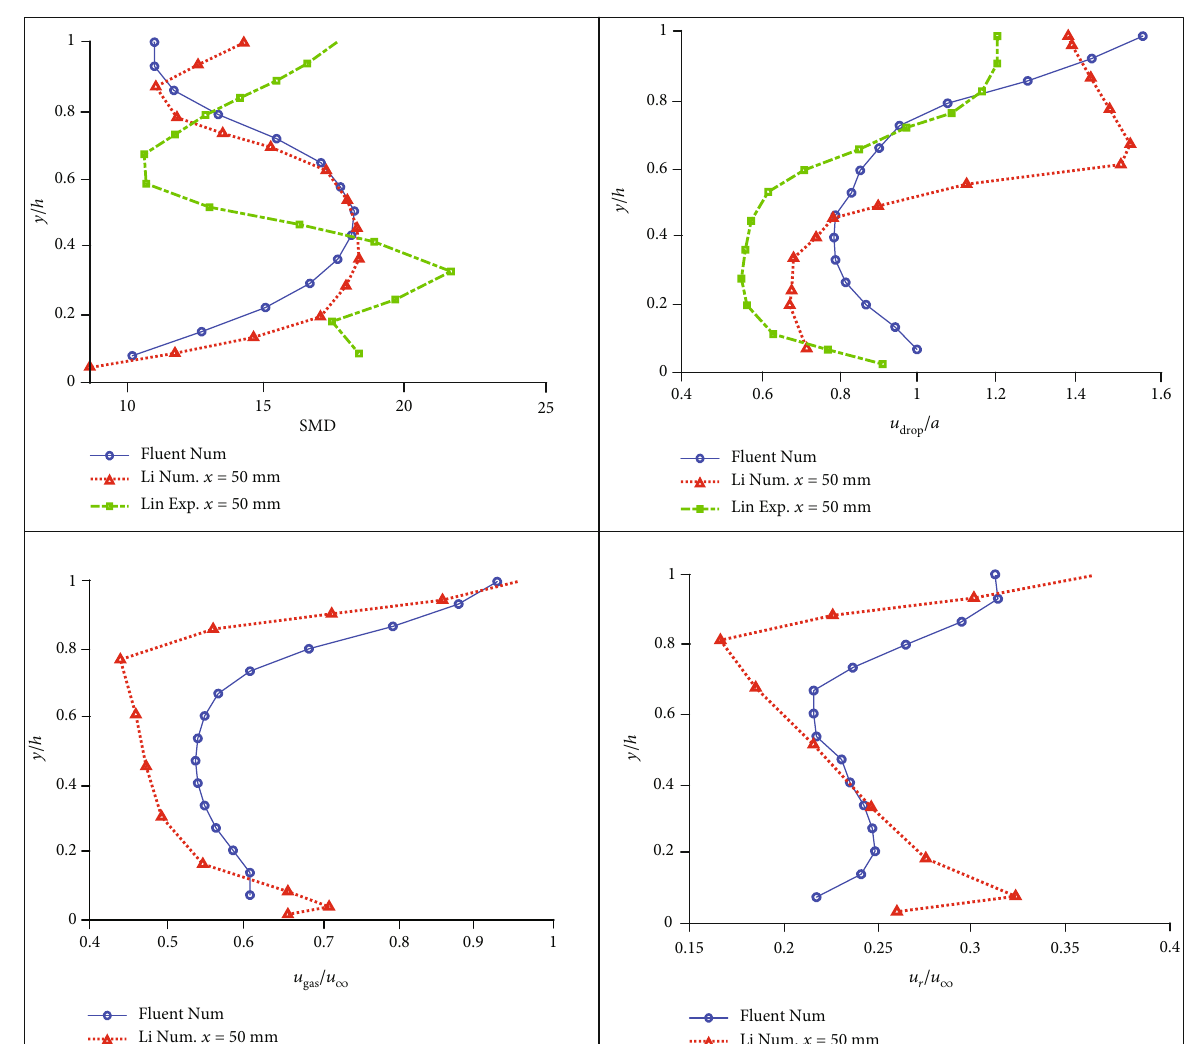
Figure 13: Comparisons of SMD, absolute, and relative velocities distributions with the simulation results of Li [13] at x = 50mm